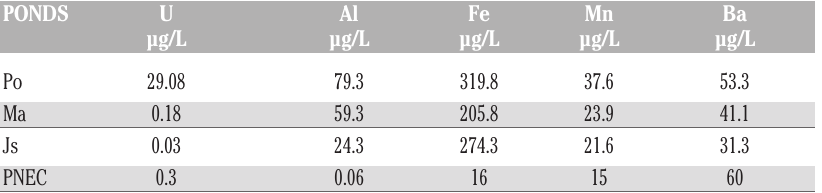
Table 1. Concentrations (µg/L) and predicted no effect concentrations (PNEC) of major metals found in the Haute-Vienne ponds on dissolved water fraction. Bold concentration values are higher than values of their respective PNEC.